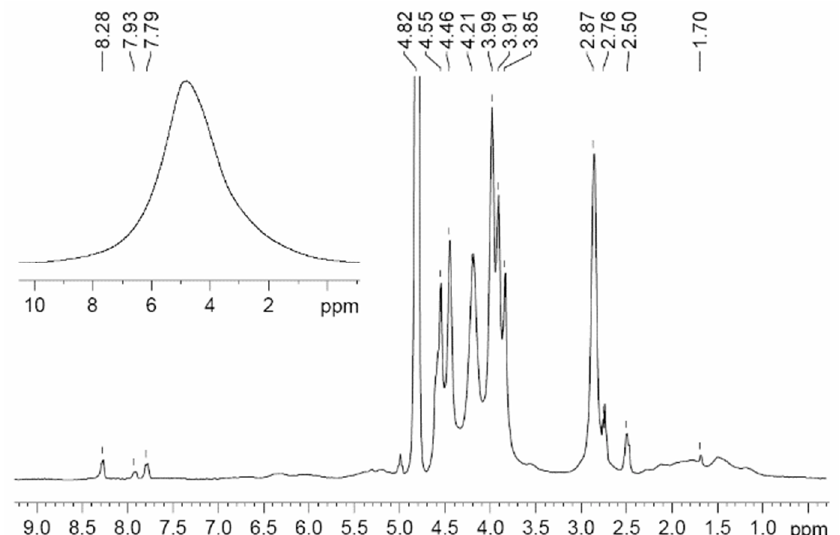
Figure 19. 1 H MAS NMR spectrum of PGE containing 54.8 wt % EC (no. 9, Table 1). Chemical shifts were measured relative to ethylene carbonate CH 2 group protons (4.82 ppm relative to TMS). The sample spinning rate is 5 kHz. The 1 H NMR spectrum without magic angle spinning is shown in the insert [54]. ( δ ): 4.82 (br.s, CH 2 , EC); 4.46, 2.76 (both br.s, CH 2 and CH 2 CO, 2-hydroxyethyl acrylate dimer); 3.99, 2.87 (both br.s, CH 2 O and CH 2 CO, polymeric units of PEDA); 1–2.50 (br.m, CH and CH 2 , cyclic groups of PEDA); 7.79, 8.28, 7.93 (all br.s, NH, H 2 C=CH, PEDA); 4.20 (br.s, OH,